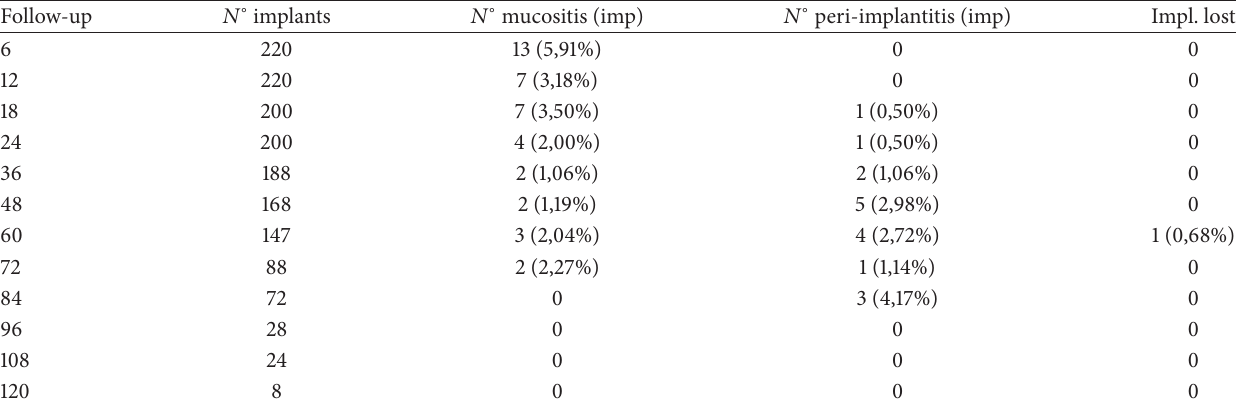
Table 3: Implant-related prevalence in the mandible.